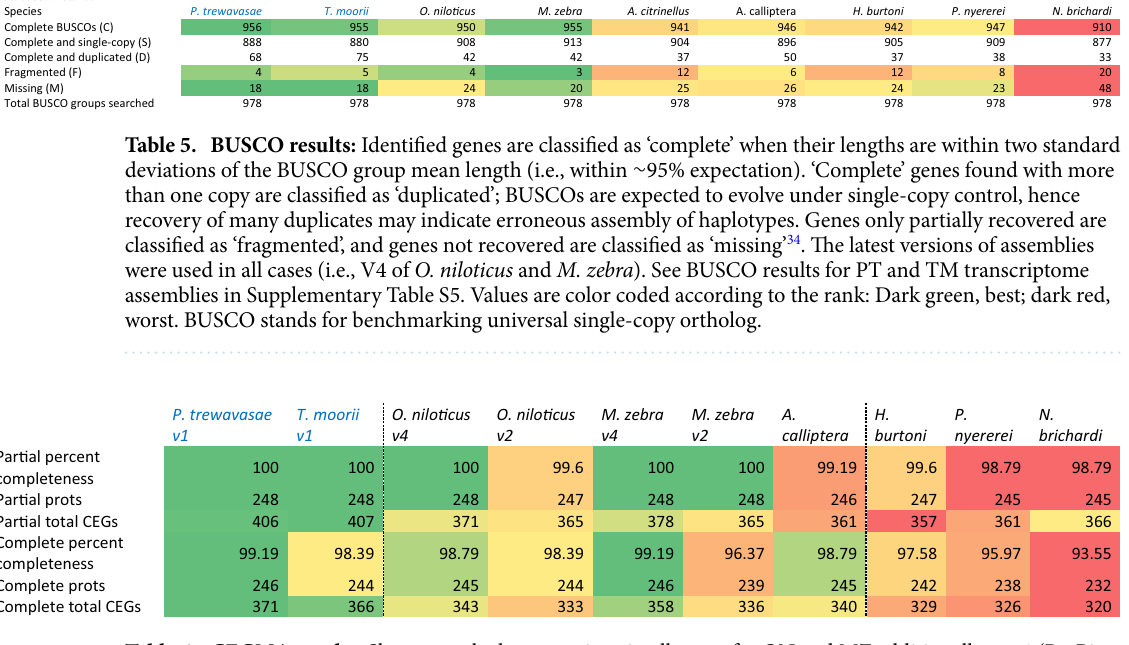
Table 6. CEGMA results: Shown are the latest versions in all cases; for ON and MZ additionally to v4 (PacBio- based) v2 (Illumina PE + MP-based) is listed for comparison (as PT and TM were primarily constructed using the same technologies). Values are color coded according to the rank: Dark green, best; dark red, worst. CEG stands for core eukaryotic gene.